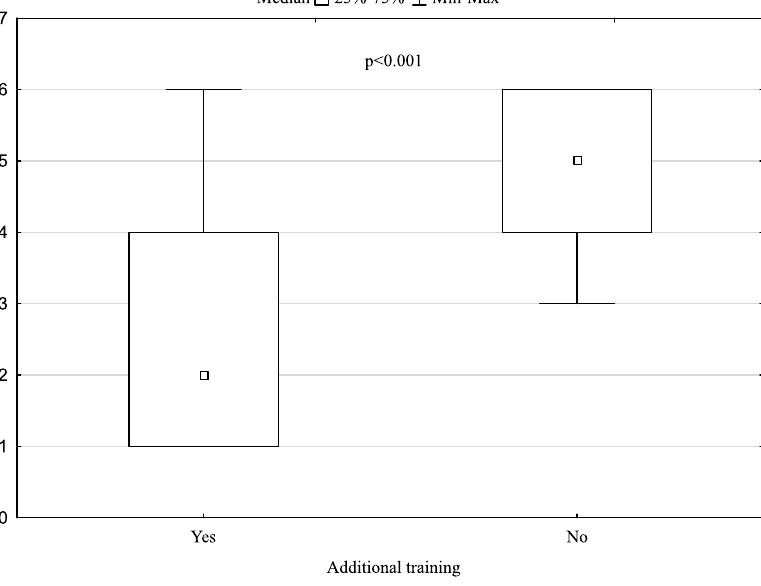
Figure 3. Length of service according to the training needs in the field of